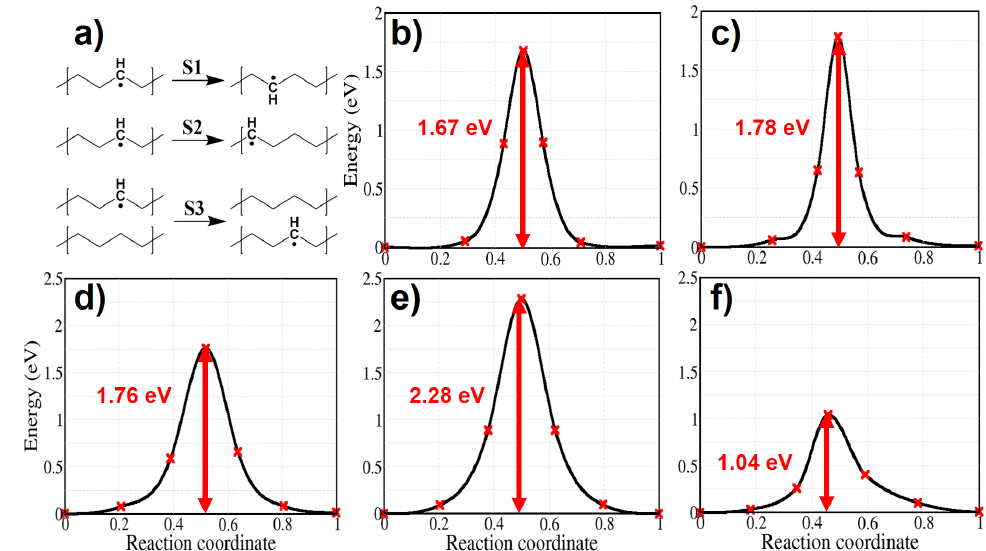
Figure 11. Energy profiles for the migration of an alkyl radical. Panel ( a ): schemes for nearest neighbor (S1) and second nearest neighbor (S2) migration along the alkane chain, and from a chain to a neighboring one (or across the chains, S3). Panels ( b , c ): energy profiles for migrations S1–S2 for the molecular model. Panels ( d , e ): migrations along the chain for the solid model; panel ( f ): migration across the chains (S3) in crystalline